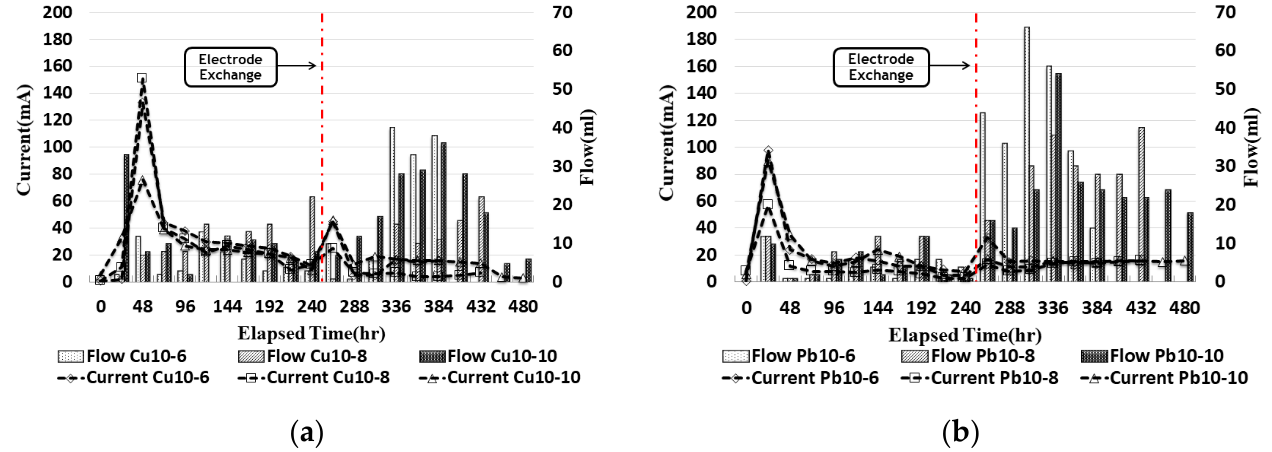
Figure 9. Current and outflow during the EK experiment: ( a ) copper; ( b ) lead.